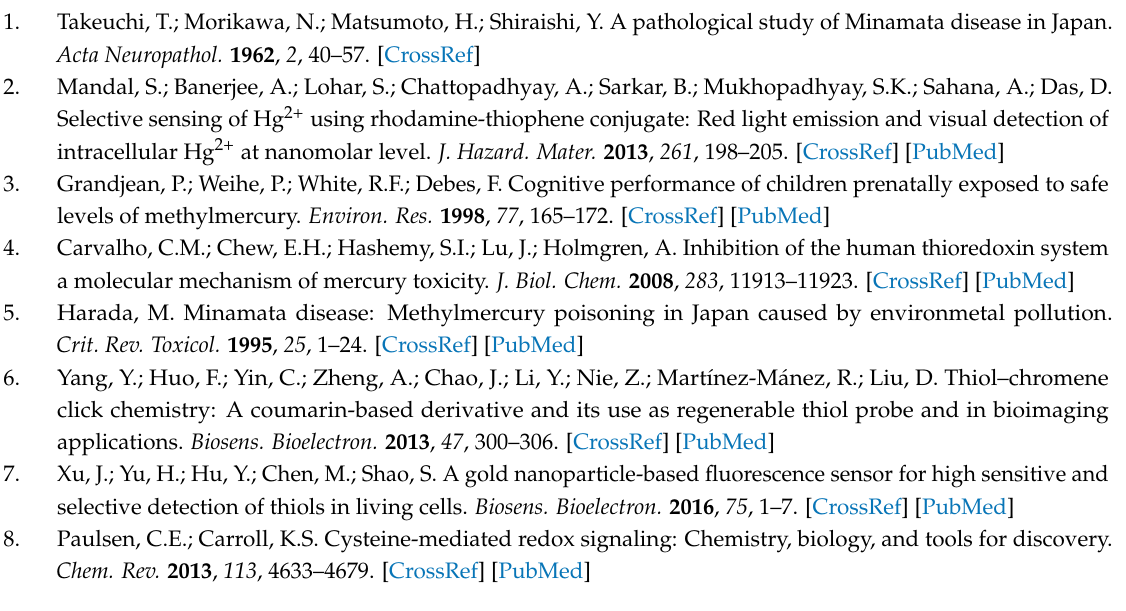
Figure 9. Reversibility of the dual-emission silica microspheres in deionized water by introducing equivalent mole of Hg 2+ and GSH.